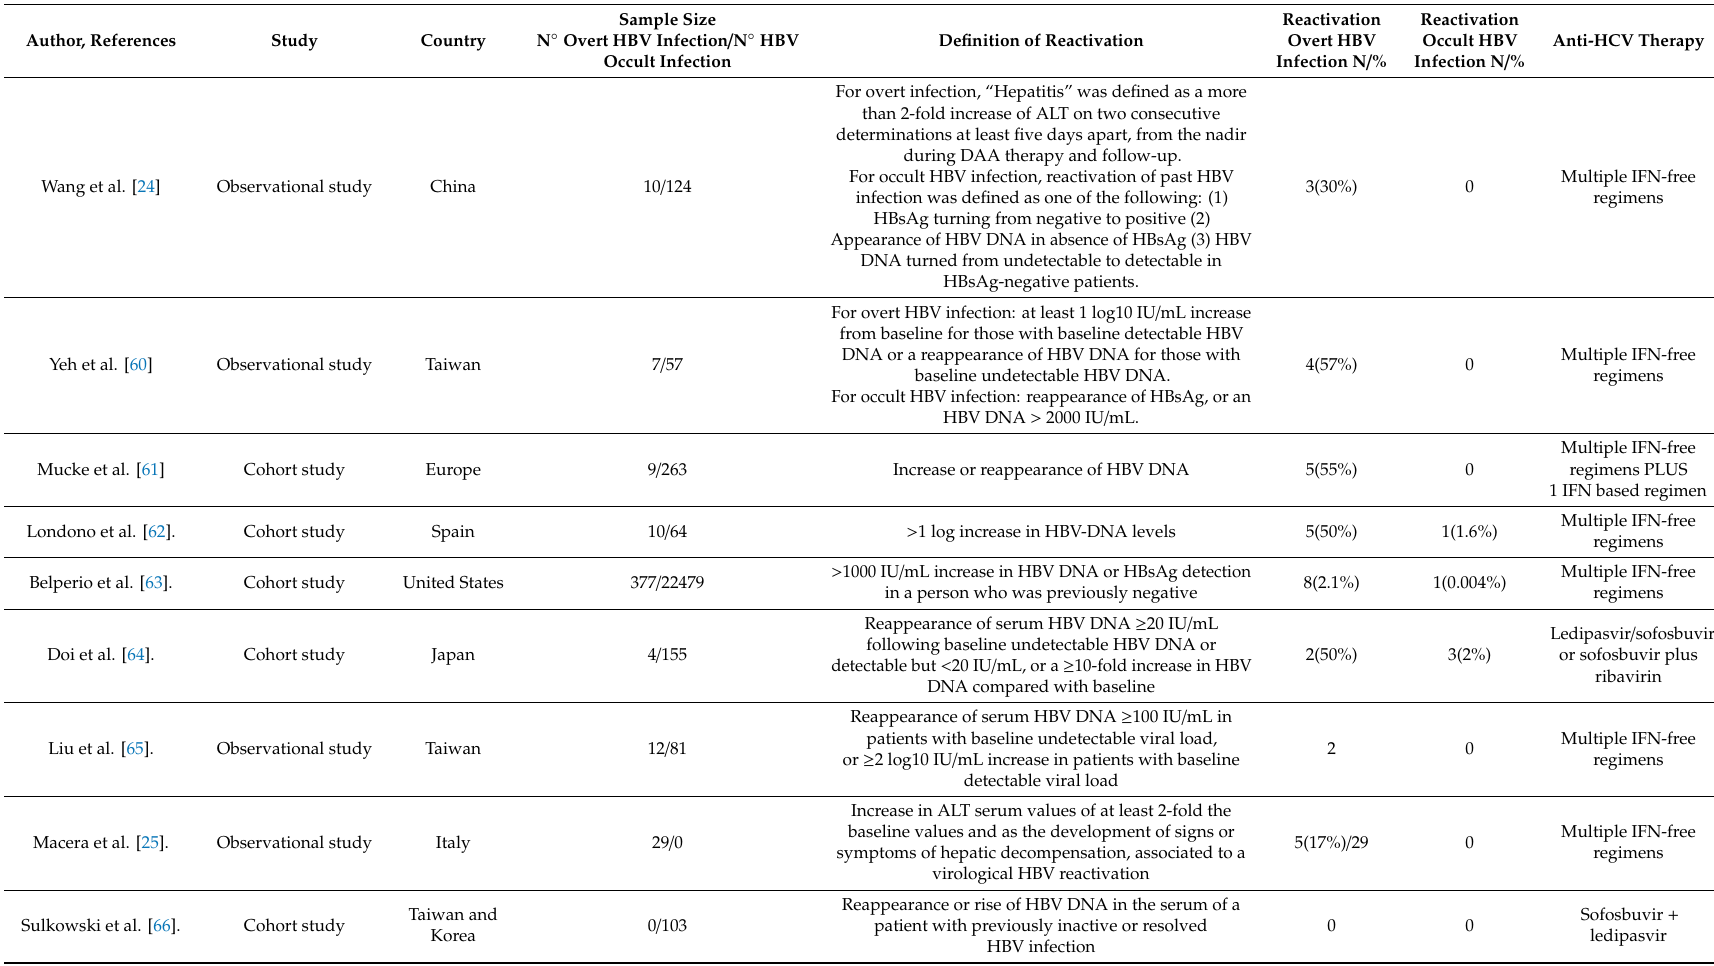
Table 2. Studies evaluating HBV reactivation in anti-HCV-positive patients treated with DAA-based